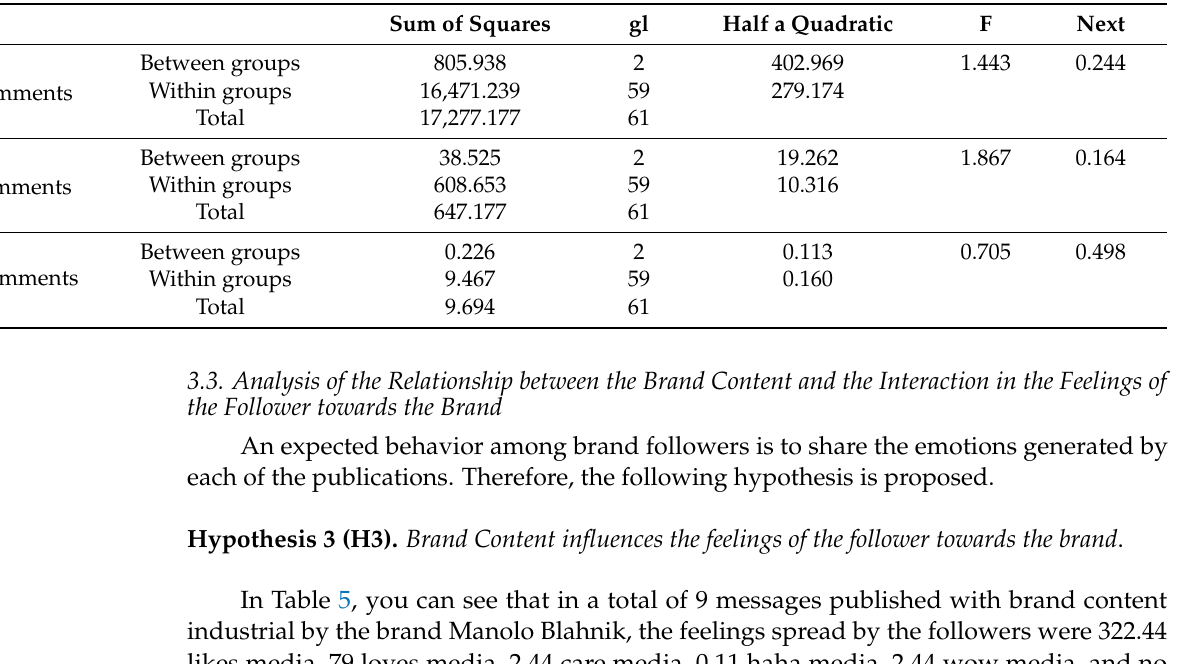
Table 4. ANOVA statistics of comments according to brand